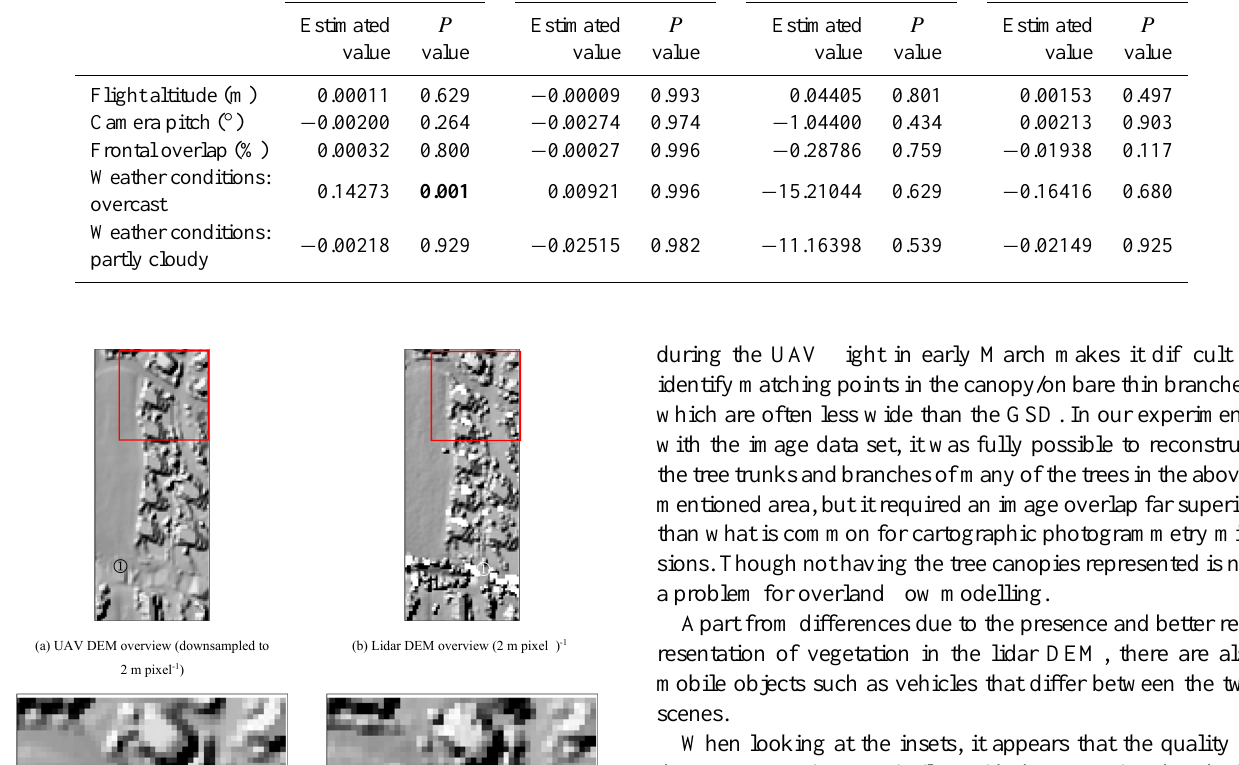
Table 5. Results of the statistical models for the quantitative metrics. Bold figures represent P values below 0.05. Terrain elevation